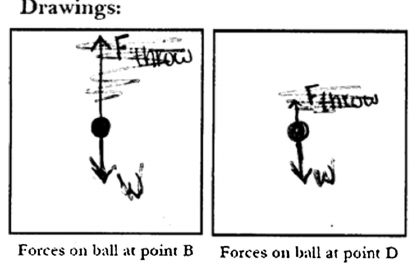
FIG. 7. Free-body diagram accompanying student response to coin toss question. Note that the crossing out of F by the instructor who graded the response, not by the